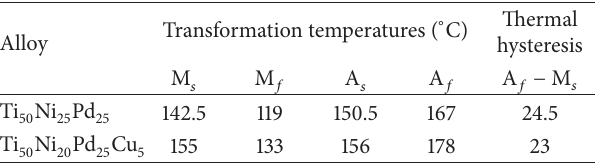
Ni Pd and 50 25 25